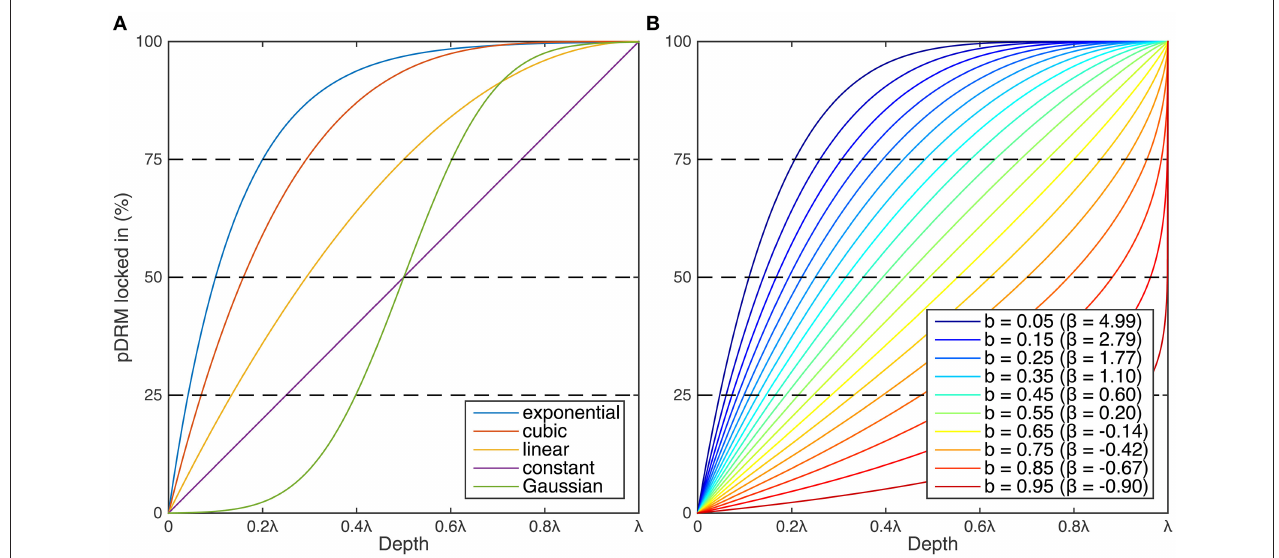
FIGURE 2 | Illustration of (A) five lock-in functions from the literature (constant, Gaussian, linear, cubic and exponential) and (B) the parameterized lock-in function, shown as the percentage of pDRM locked in with depth, i.e., the cumulative functions. The shape of the parameterized lock-in function is determined by the lock-in shape, β , and corresponding transformed parameter, (B) . The Gaussian and exponential functions have been truncated at